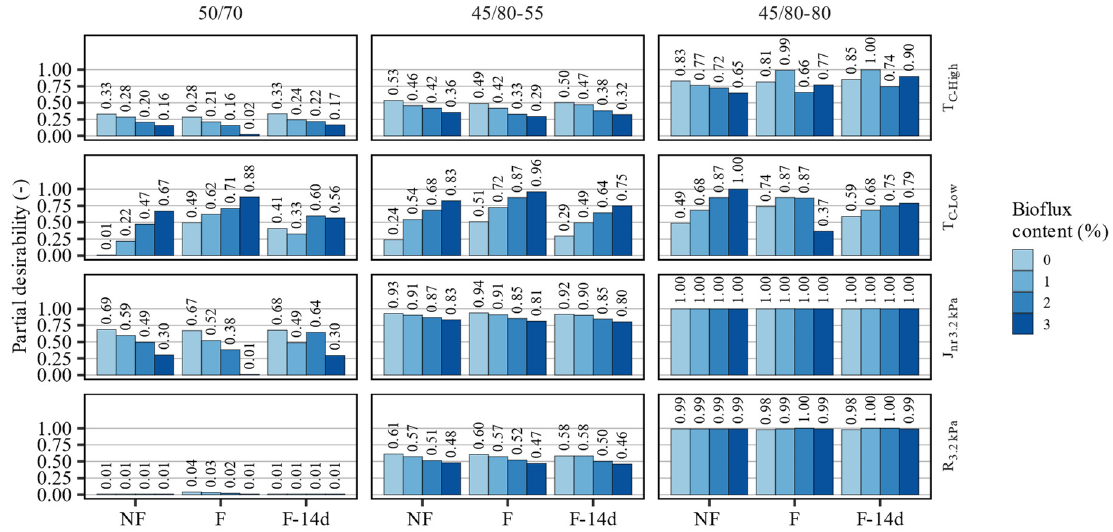
Figure 10. The computed partial desirability values with respect to the evaluated characteristics of investigated asphalt binders.